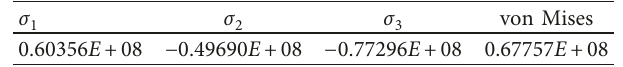
Table 7: The maximum principal stress and maximum von Mises stress of column system